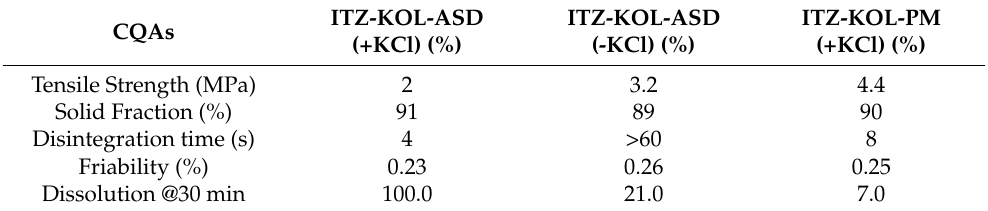
Table 7. CQAs responses for tablets of ITZ-KOL-ASD( ± KCl) and